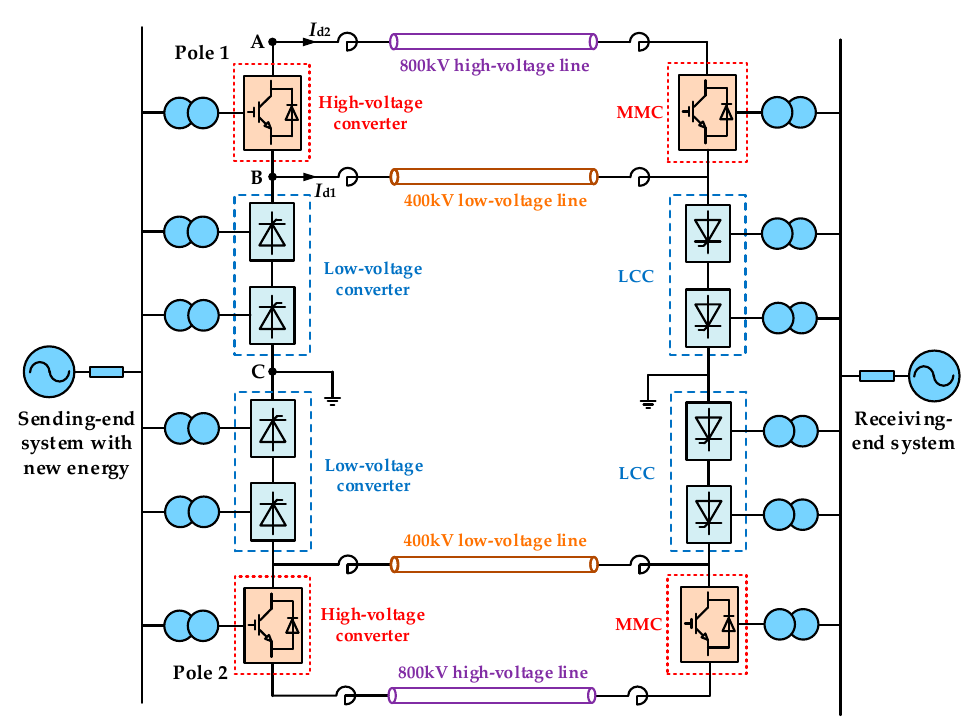
Figure 3. Structure of hybrid hierarchical HVDC system.